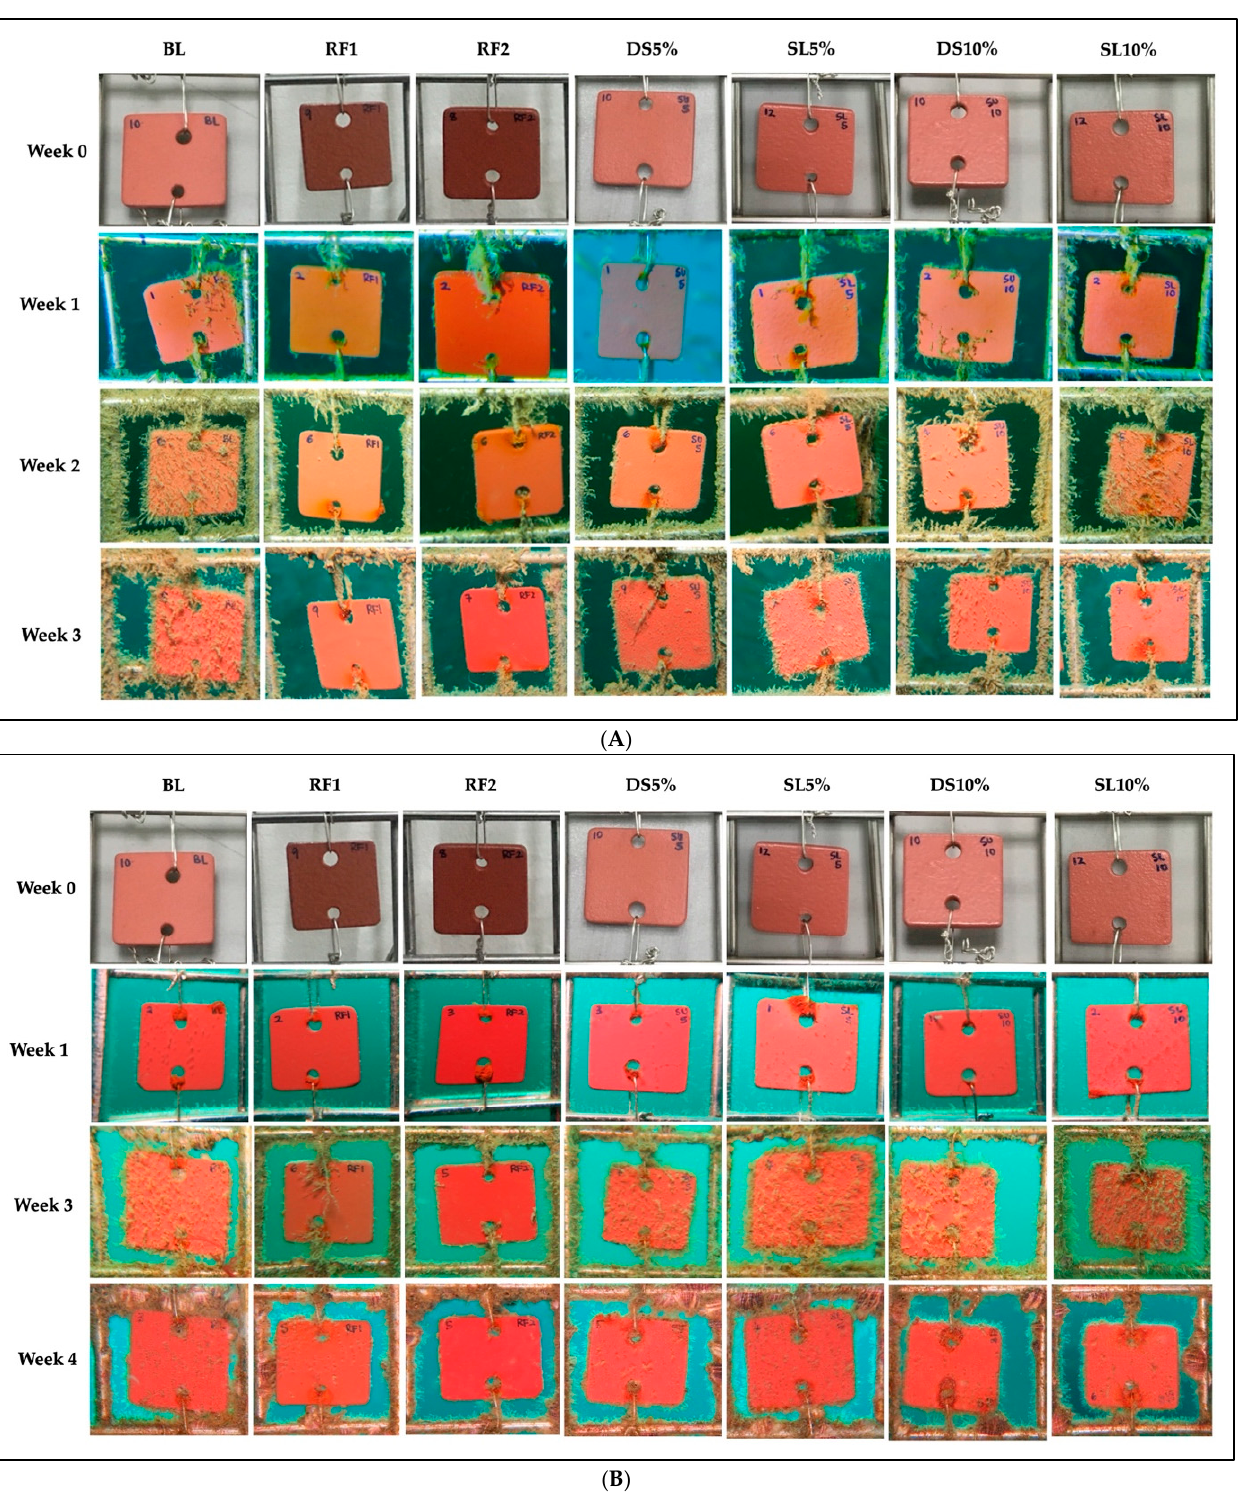
Figure 11. Underwater images of different coated panels in the seawater at Kemaman ( A ) and Pulau Redang ( B ). Panel coated with blank paint (BL); Panel coated with commercial antifouling paint (RF1 and RF2); DS5% and DS10% ( w / v ): Paint with D. setosum crude extract; SL5% and SL10% ( w / v ): Paint with S. lanceolata crude extract.